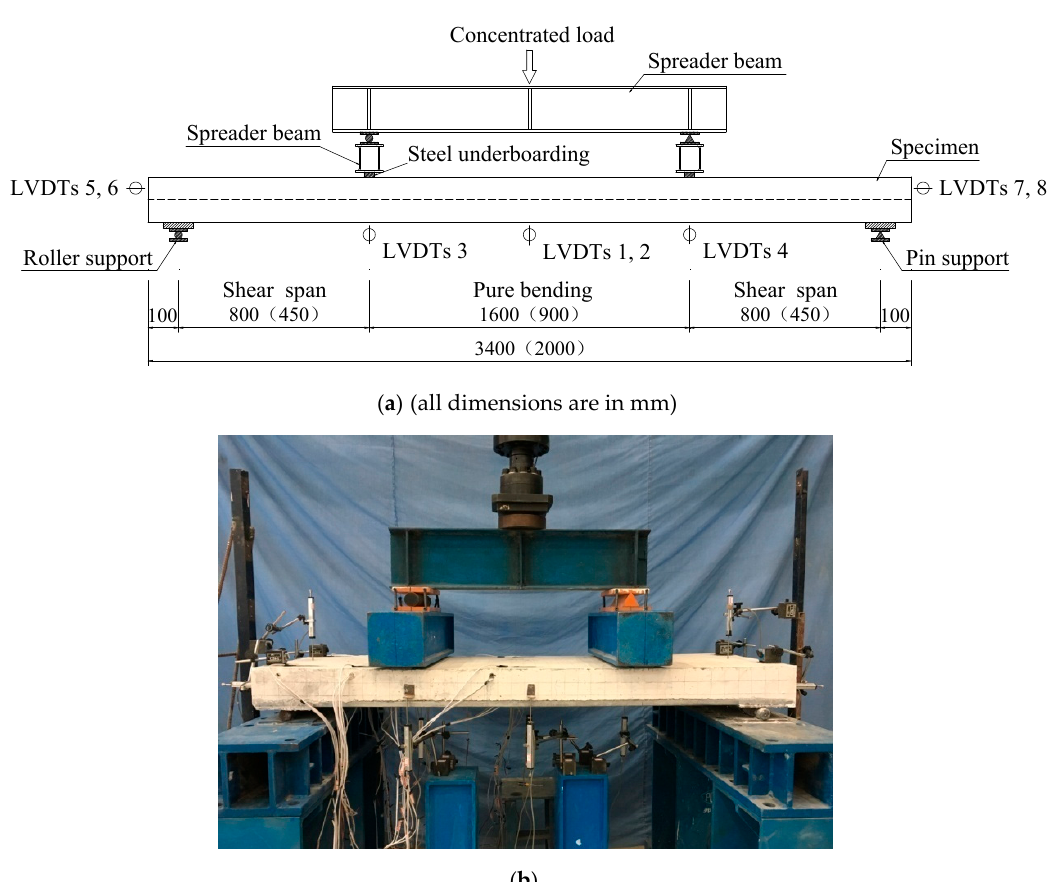
Figure 5. ( a ) Schematic diagram of test set-up and ( b ) Actual test set-up.